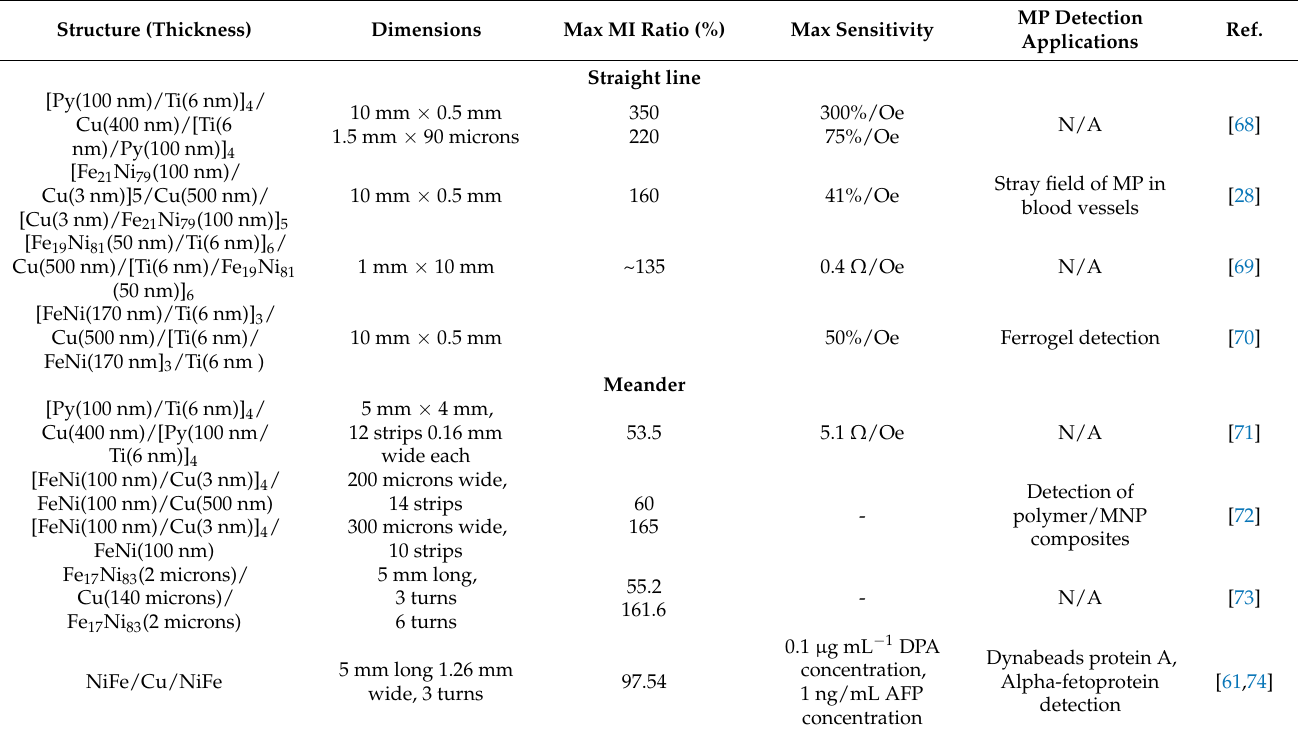
Table 1. Thin-film structures and MI ratios